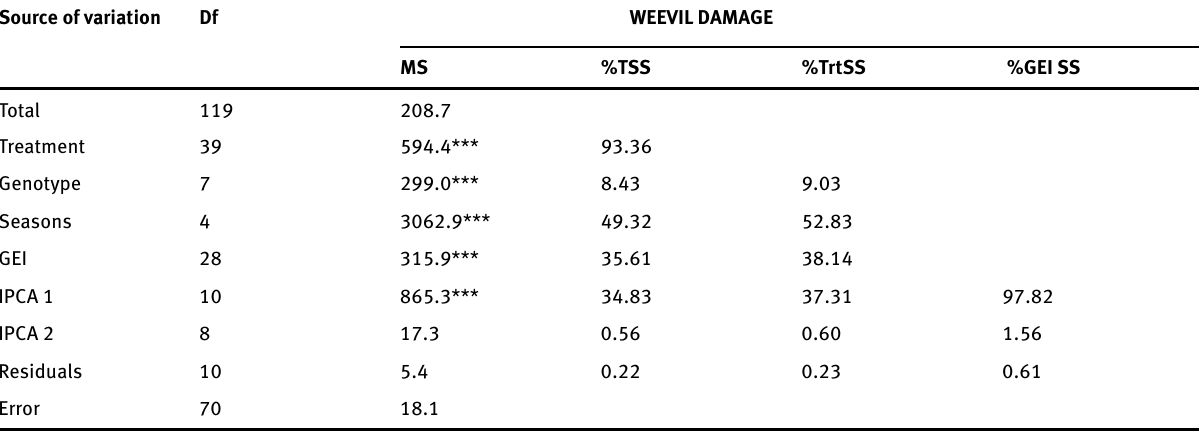
Table 2 Summary of AMMI analyses for sweetpotato weevil damage Source of